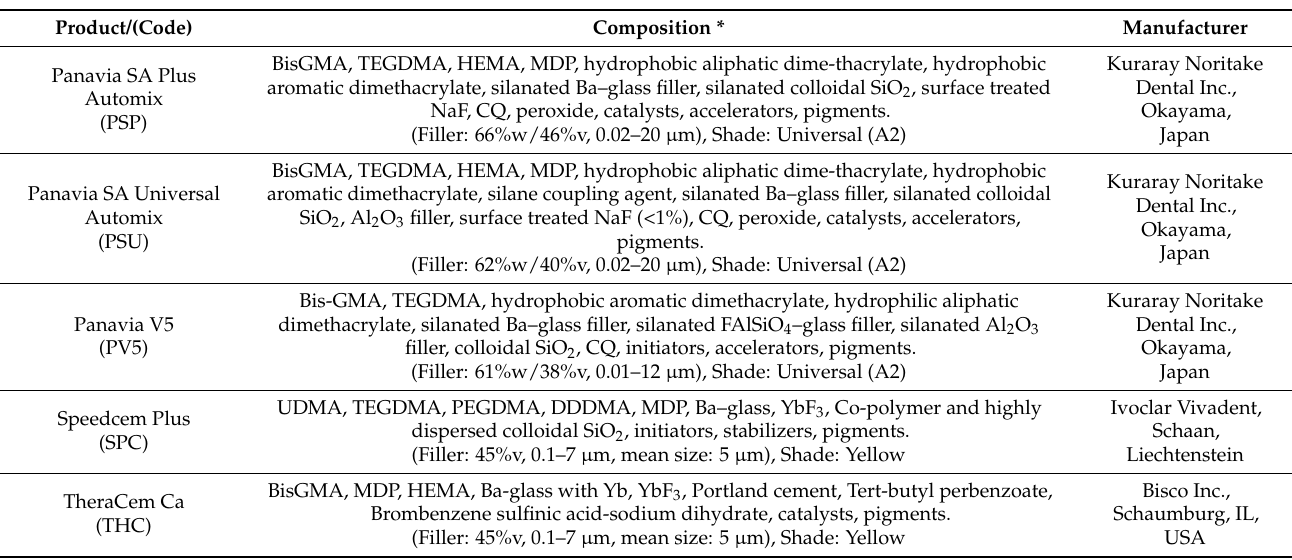
Table 1. The materials